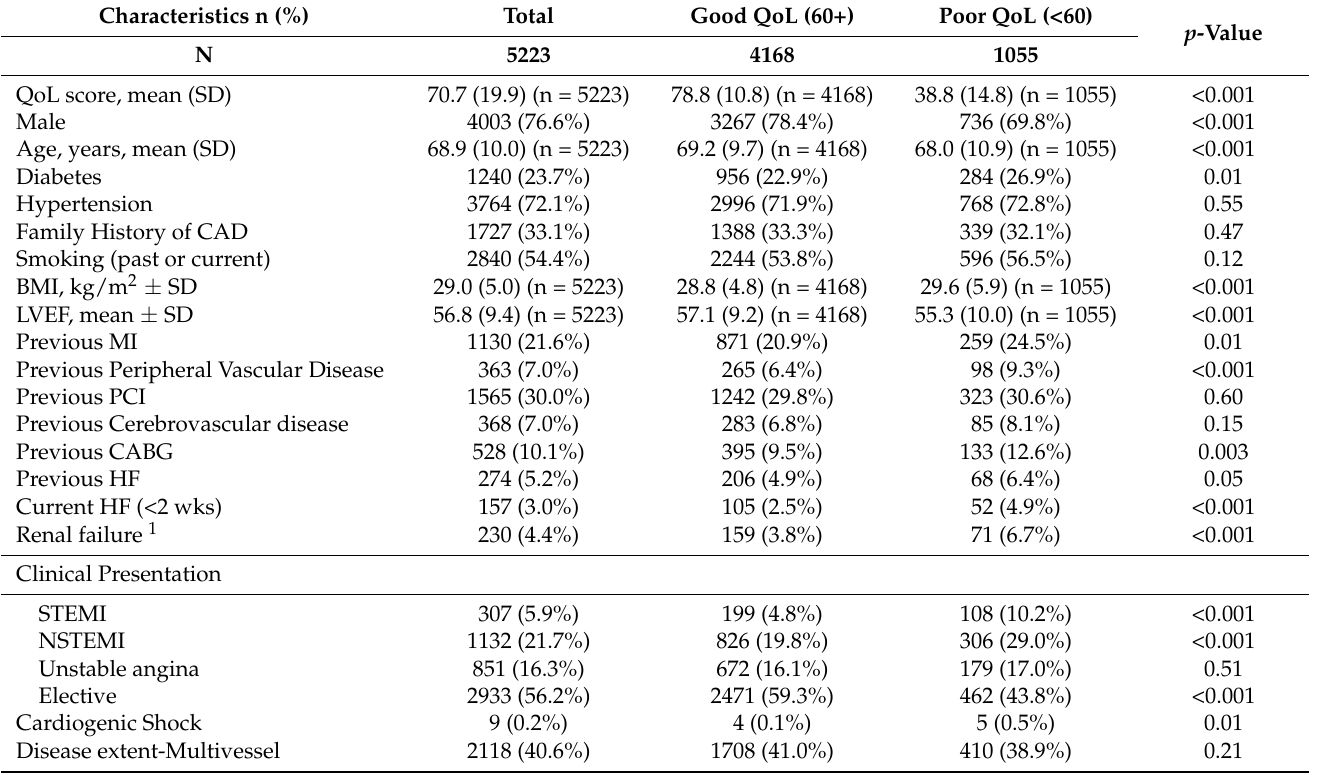
Table 1. Baseline demographics and clinical presentation of patients by good and poor QoL based on VAS score.